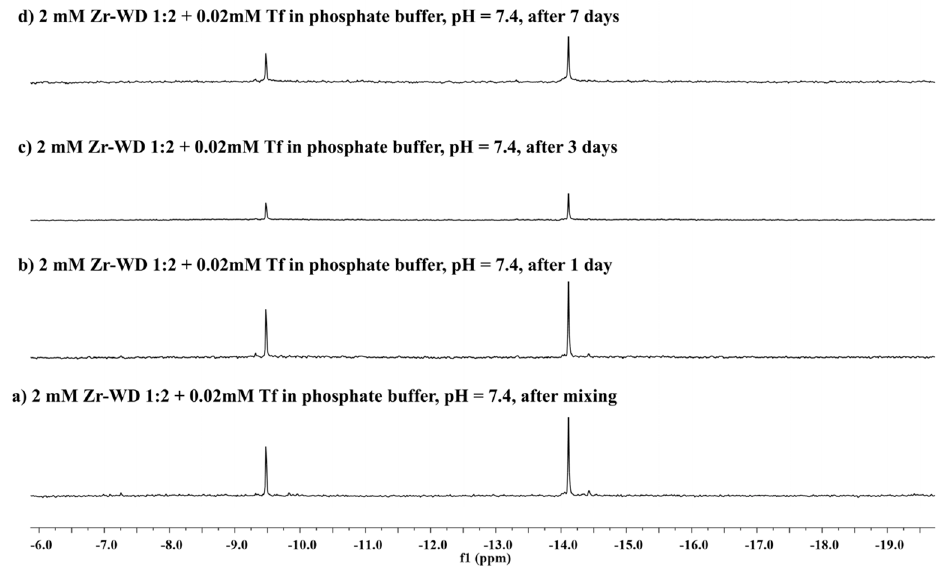
Figure 5. 31 P-NMR of Zr-WD 1:2 (2 mM) incubated in the presence of transferrin (20 µM) in phosphate buffer (10 mM, pH 7.4) at 60 °C. Incubation times are shown in the figure. The Zr-WD 1:2 structure ( − 14.11 and − 9.548 ppm) remains largely stable over time.